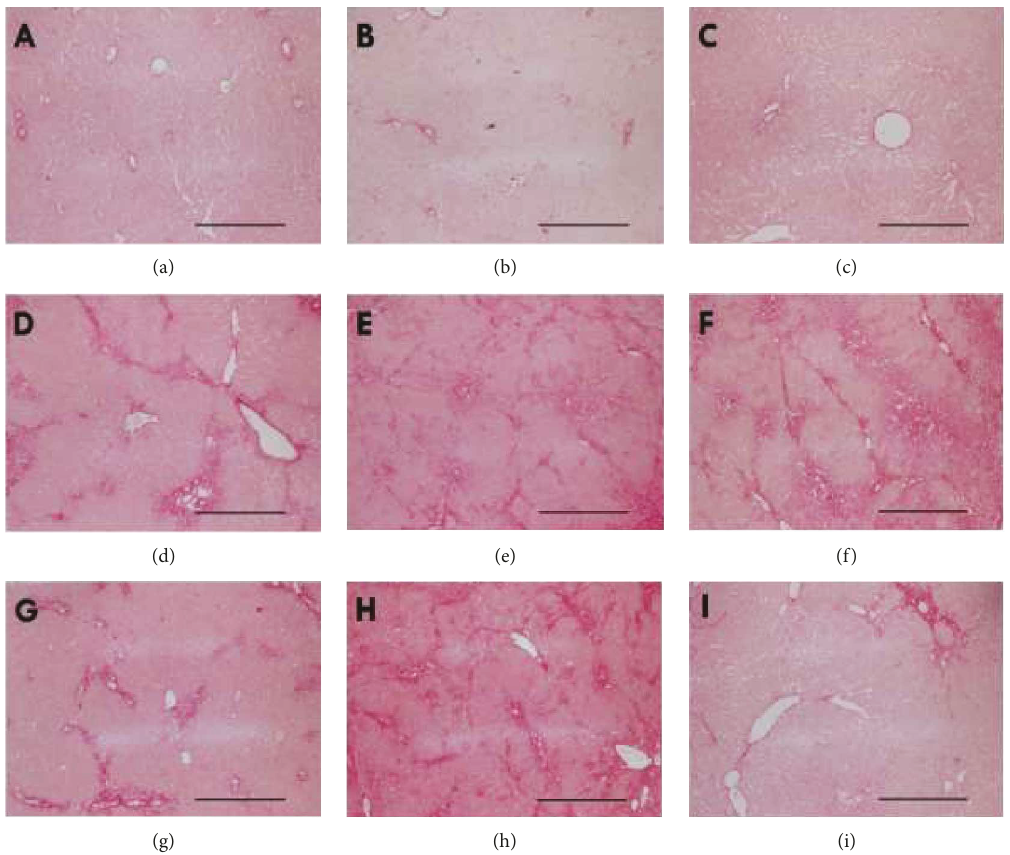
Figure 3: Representative histological sections stained with sirius red from the three studied groups on the 2nd, 4th, and 6th postoperative weeks. In the SS group, no changes were noticed (a – c). In the BDL group, a progressive ductular reaction and periportal fi brosis were evident along the postoperative weeks (d – f). In the BDL+AM group, a progressive ductular reaction and periportal fi brosis were noted on the 2nd and 4th postoperative weeks (g and h). However, a marked reduction in liver fi brosis was evident on the 6th postoperative week (i). SS: sham surgery; BDL: bile duct ligature; BDL+ AM: bile duct ligature plus amniotic membrane; PO: postoperative. Scale bar represents 200 μ m. Table 3: Collagen quanti fi